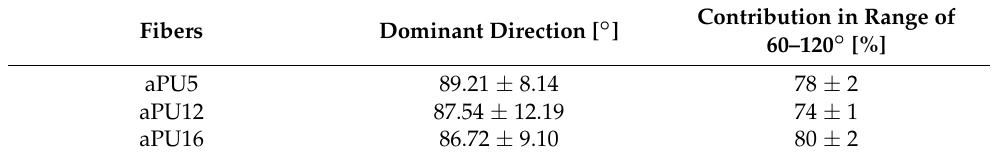
Table 2. The degree of the fibers’ alignment within the